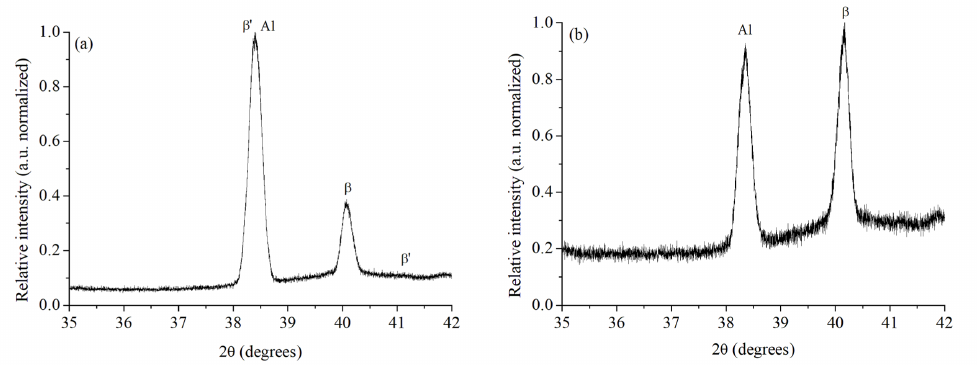
Figure 10. Microdiffraction patterns in the HAZ for selected samples ( a ) M2 in the original AA6061– T6 condition, and ( b ) M6 heat treated AA6061–T4. The peak intensity is normalized to the most relevant peak.